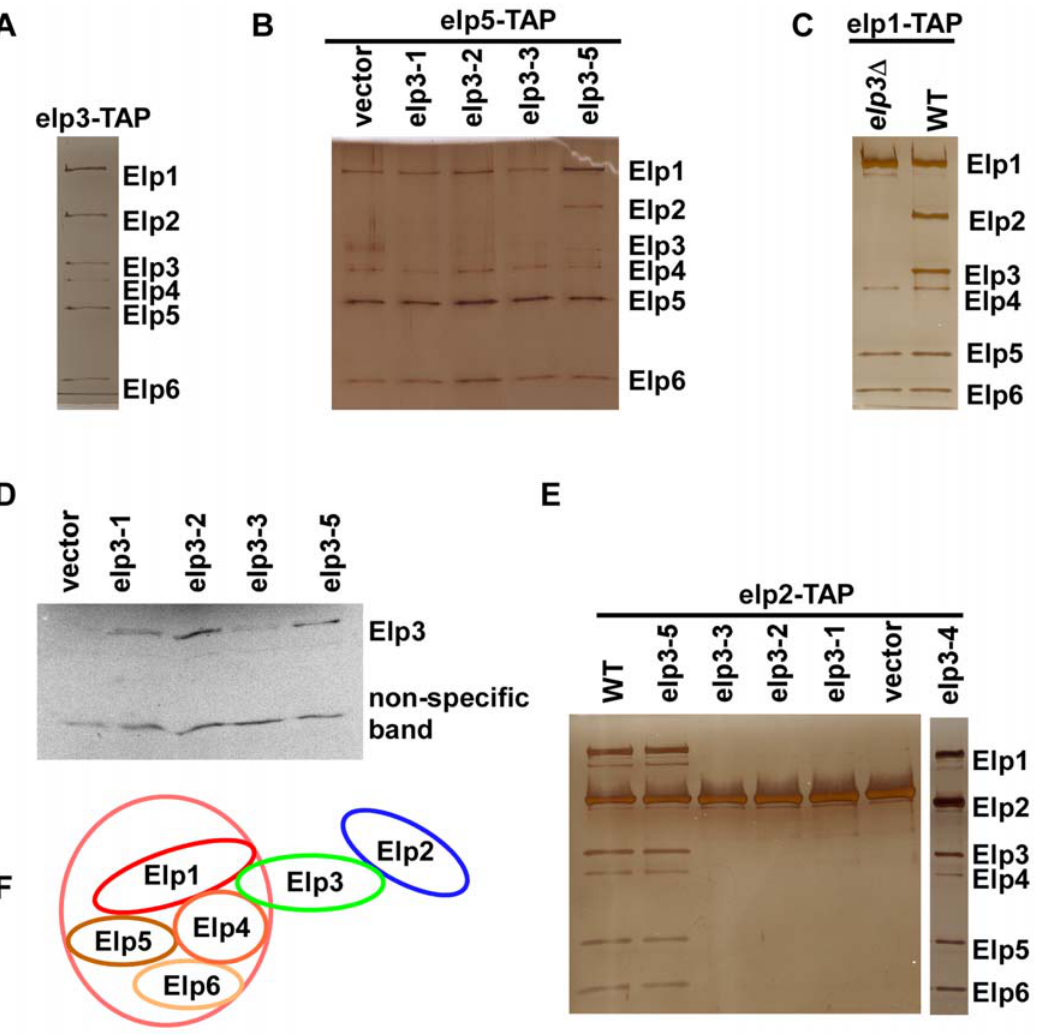
Figure 3. Mutations at the SAM domain, but not at the HAT domain, of elp3 perturb the integrity of the Elongator complex. (A) Elp3 forms a complex with five other subunits of Elongator. The Elongator complex was purified from cells expressing Elp3-TAP and the purified proteins were visualized by silver staining. (B) Three elp3 site-specific mutants affect formation of the Elongator complex. Plasmids for wild type Elp3, elp3-1 , elp3-2 , elp3-3 and elp3-5 were introduced into the strain in which the ELP3 was deleted and ELP5 was tagged with the TAP epitope ( elp3 D elp5-TAP ). Proteins associated with Elp5 were purified, resolved on SDS PAGE and revealed with silver staining. As a negative control, Elp5 was also purified from a strain transformed with empty vector (vector). (C) Elp1 molecules associate with Elp4–6 subcomplex in the absence of Elp3. Elp1 molecules were purified from wild type or elp3 D mutant cells using the TAP tag and purified proteins were analyzed on SDS-PAGE and visualized by silver staining. (D) Analysis of expression of elp3 mutants by Western blot. Whole cell extracts from cells expressing wild type Elp3 or each of the site-specific elp3 mutants were analyzed by Western blot using antibodies against the Flag epitope, which was fused to the C-terminus of Elp3 or each site-specific mutant of Elp3. (E) Mutations in the Radical SAM domain of Elp3 affect the binding of Elp3 to Elp2. Elp2 proteins were purified from yeast cells expressing wild type Elp3 and each of the four site-specific elp3 mutants ( elp3-1 , elp3-2 , elp3-3 and elp3-5 ) using Elp2-TAP and co-purified proteins were detected by silver staining. (F) A model of the subunit organization of the Elongator complex highlighting the interaction between Elp2 and Elp3 is important for Elp2 to incorporate into the Elongator complex and the Elp1, Elp4, Elp5, and Elp6 proteins form a core complex.